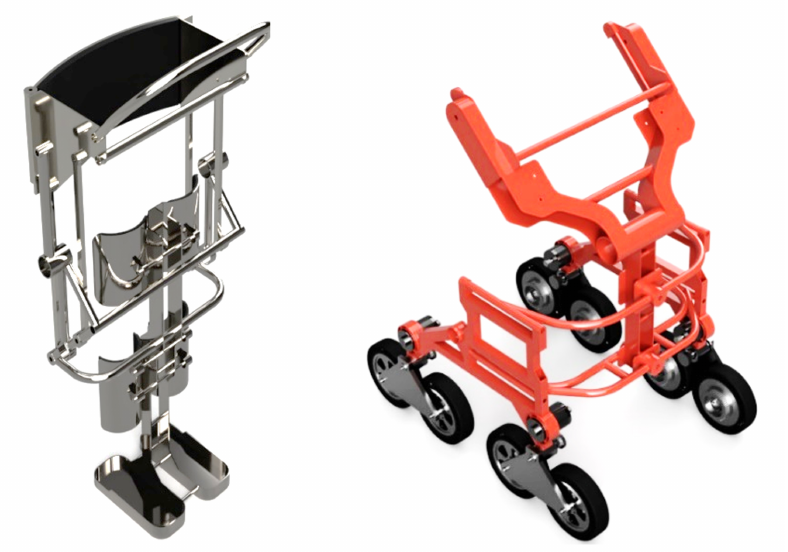
Figure 5. Seated-standing Mechanism. ( Left ) Exoskeleton, ( Right ) Mobility structure.